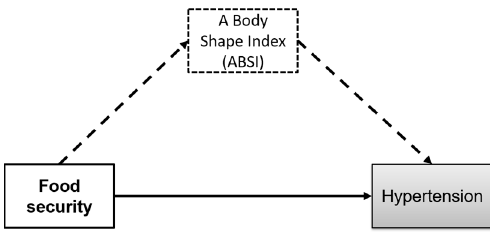
Figure 1. A Body Shape Index may mediate the relation between food security and hypertension.